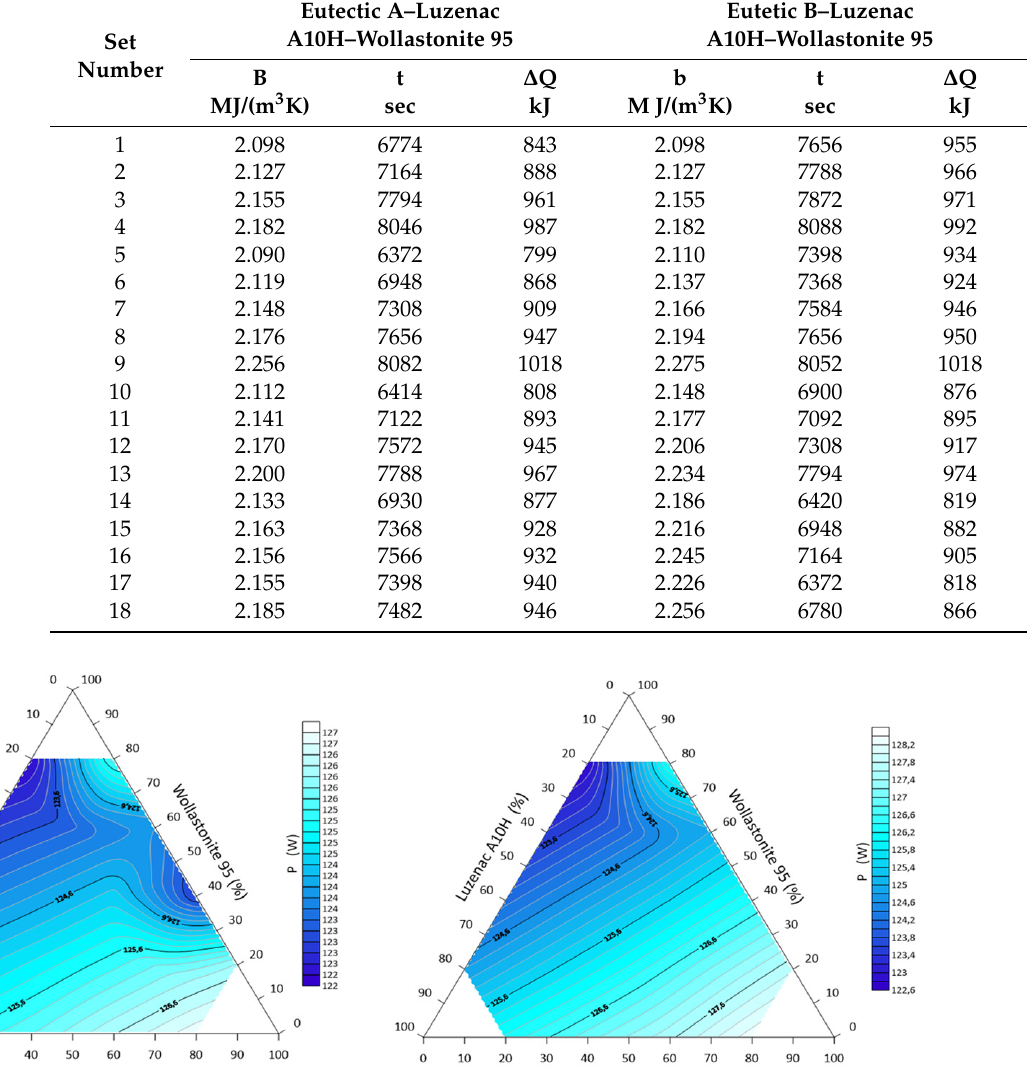
Table 4. Volume heat capacity b , time t of eutectic formation, and transformation energy ∆ Q of the investigated sets.